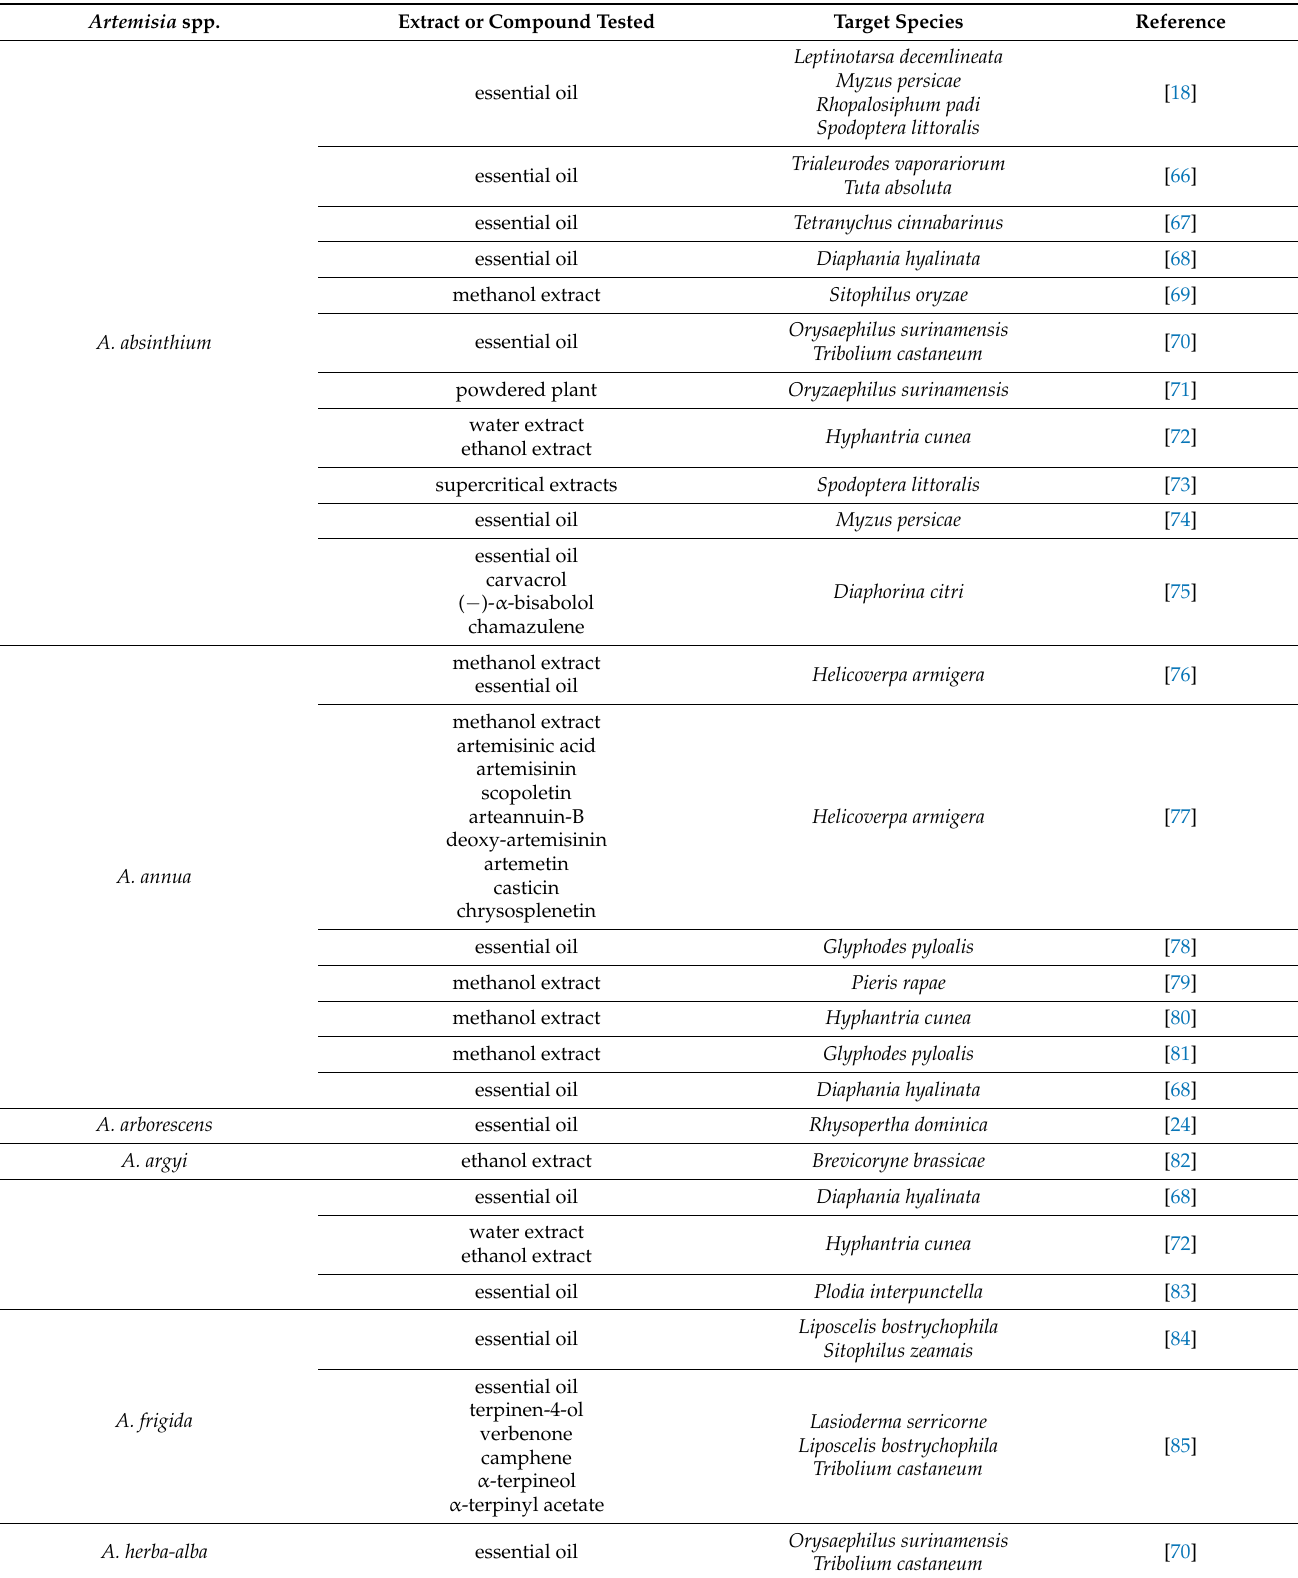
Table 2. Insecticidal activity of Artemisia compounds and